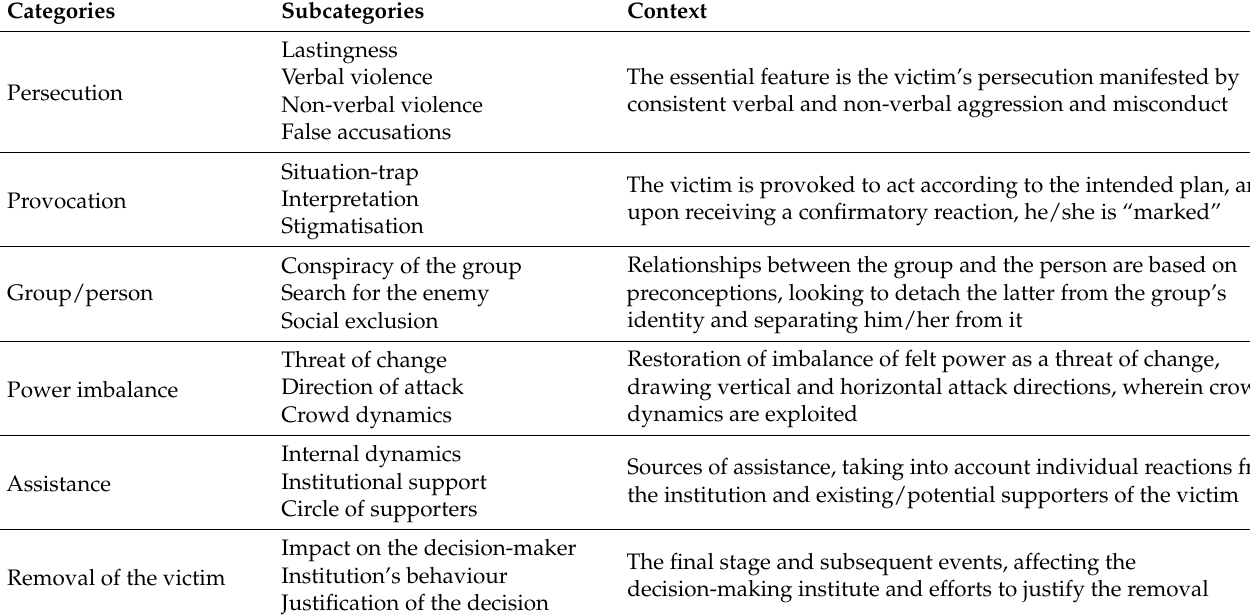
Table 1. Categories and